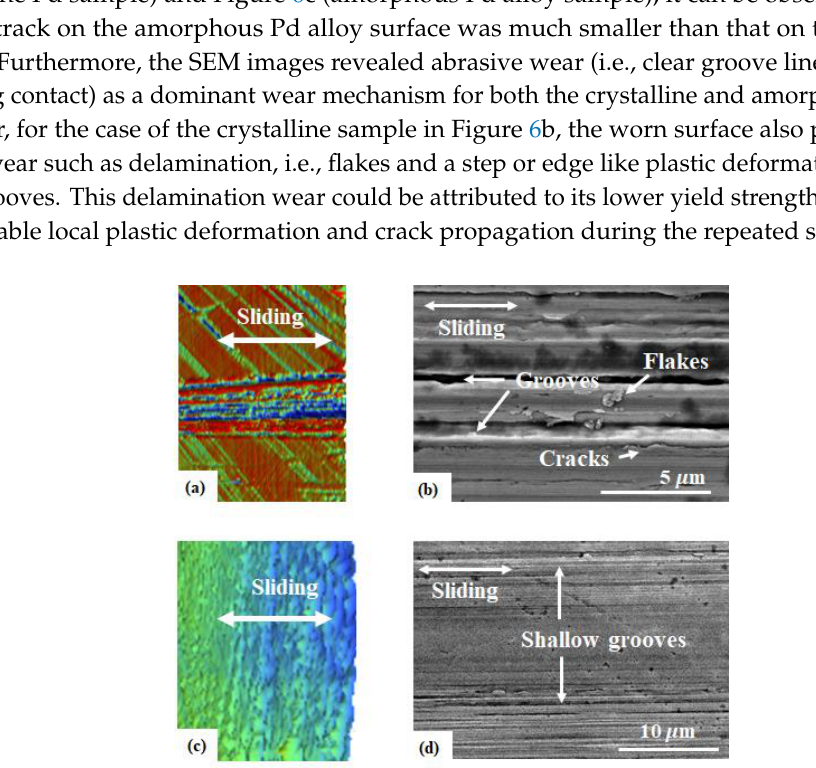
Figure 6. The morphologies of the worn surfaces: ( a ) 3D topography and ( b ) SEM image of crystalline Pd with sliding speed of 3 mm/s and ( c ) 3D topography and ( d ) SEM image of amorphous Pd alloy with sliding speed of 3 mm/s under the IL lubrication at ambient temperature.